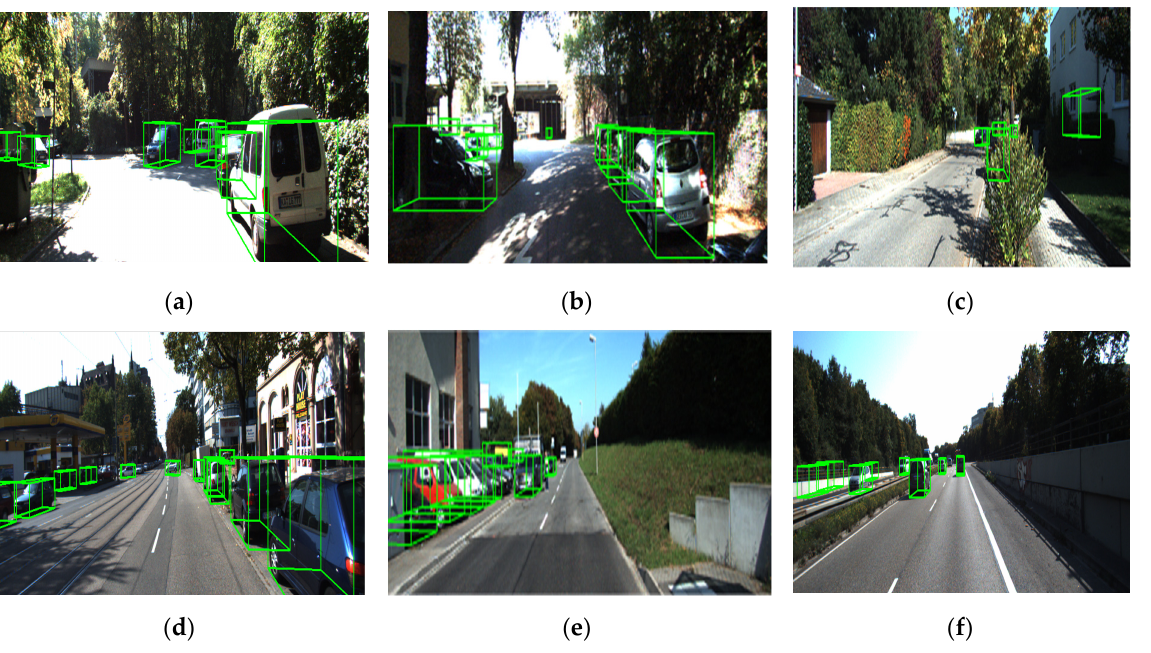
Figure 12. Comparison of detection results of PointRCNN algorithm. ( a – f ) show the detection of the same scenario with the PointRCNN algorithm.